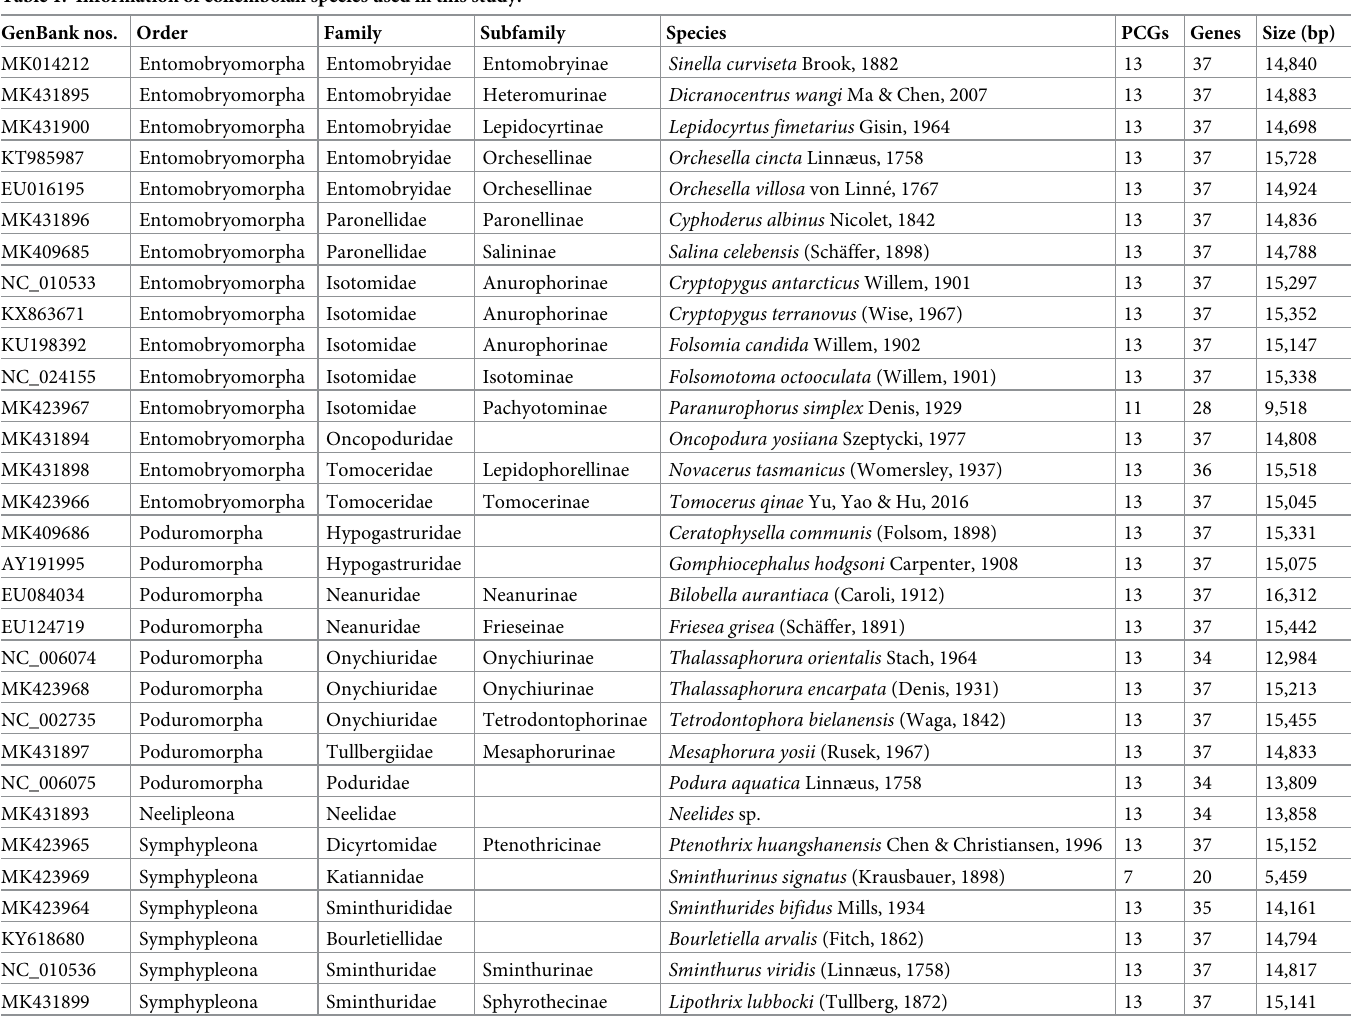
Table 1. Information of collembolan species used in this study. GenBank nos.